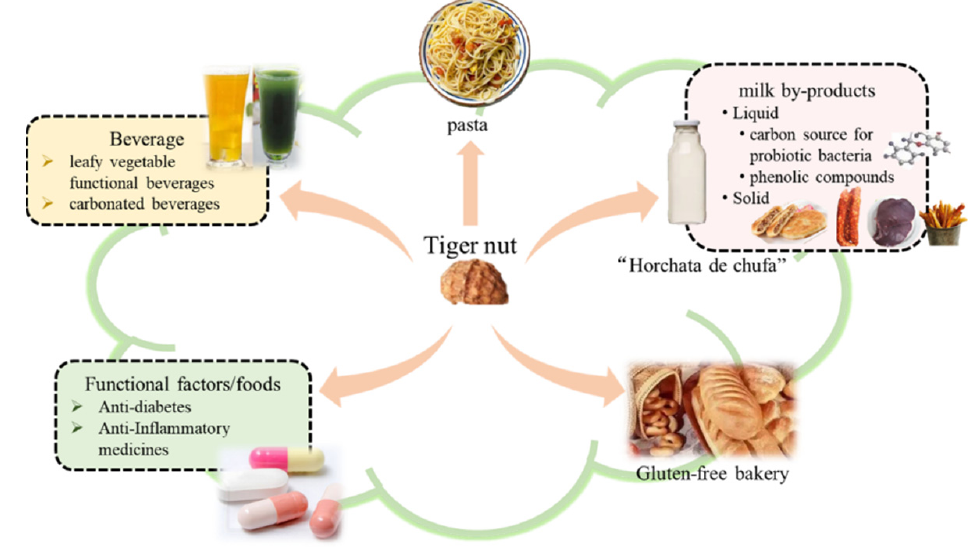
Figure 3. Applications of the whole tuber of the tiger nut in the food industry.